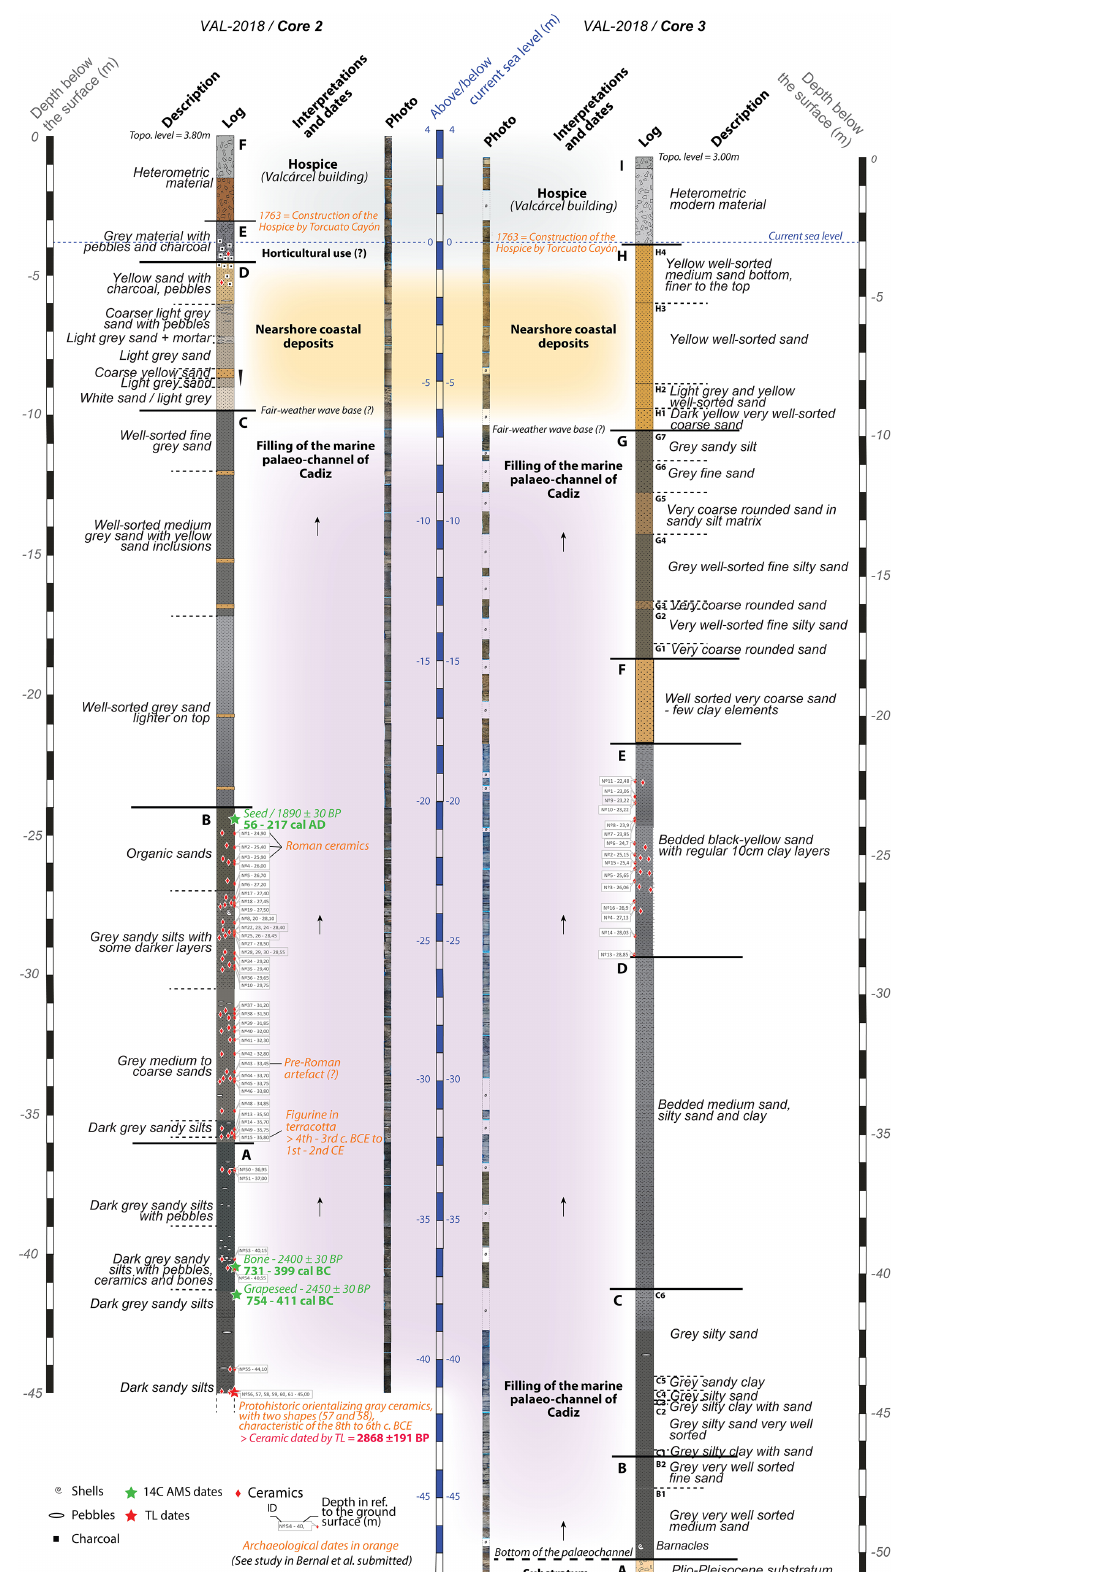
Figure 4. Stratigraphic sequences of VAL-18/Cores 1, 2, and 3 with preliminary dates (radiocarbon dates, thermoluminescence dates,